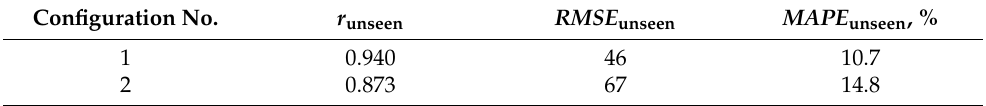
Table 6. Performance of selected artificial neural networks on “unseen” data. Configuration No.